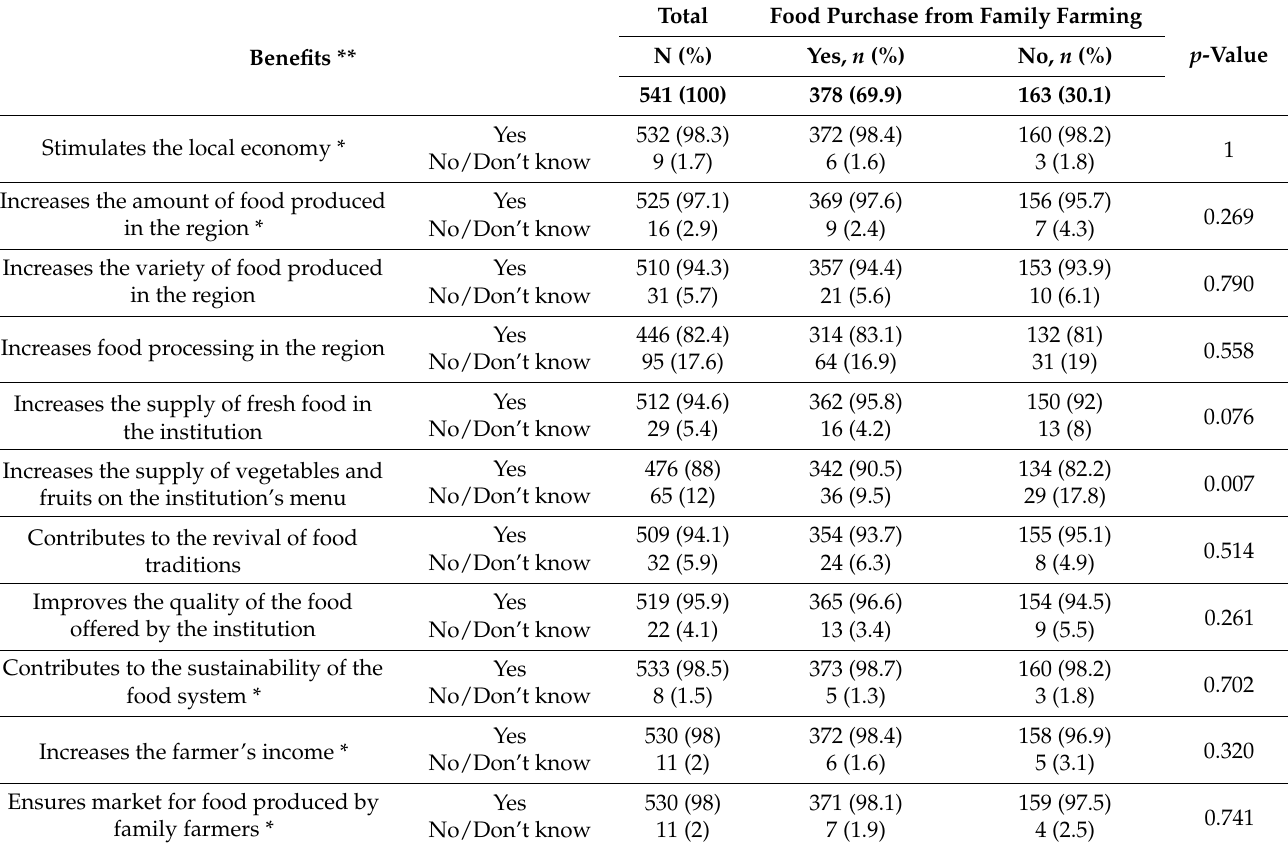
Table 2. Opinion of study participants concerning the benefits of buying food from local family farming in public institutional food service, stratified according to the family farmers’ food